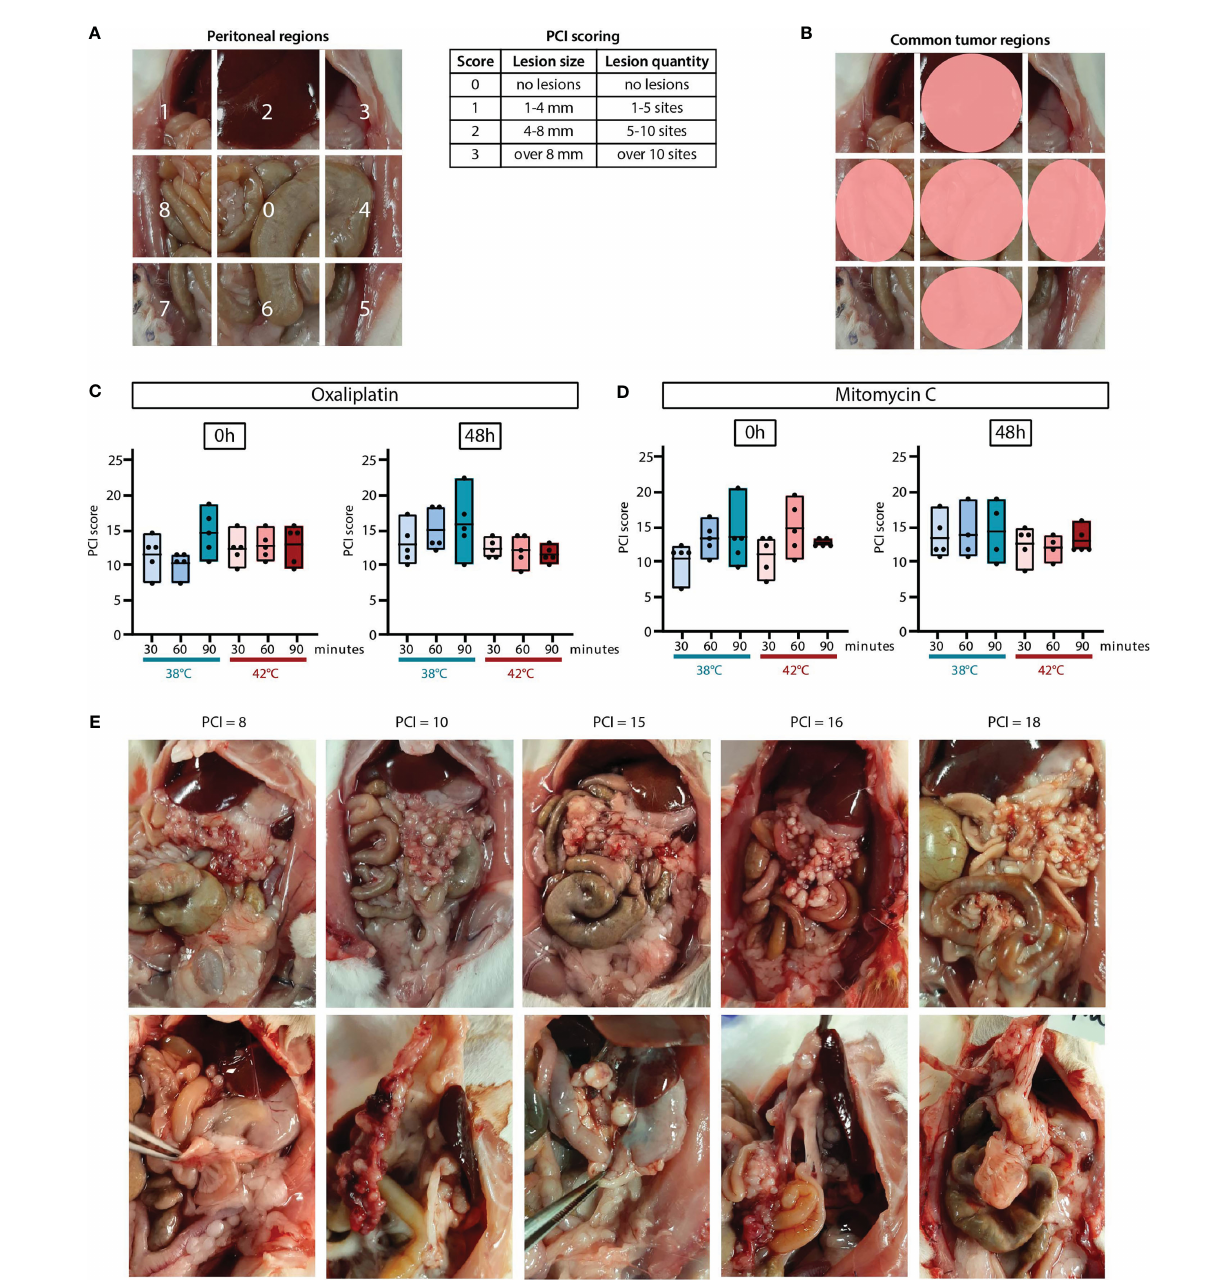
FIGURE 3 The extent of disease was scored upon sacri fi ce using the peritoneal carcinomatosis index (PCI) score. The number and size of the tumor lesion were scored in 9 regions with a score of 0, 1, 2 or 3 (A) . Tumor lesions were most common in regions 2, 0, 4, 6 and 8 (B) . PCI scores measured 0 hours and 48 hours after HIPEC treatment with oxaliplatin (C) or MMC (D) . All values of 4-5 animals are presented with the min/max ± means. Representative pictures with corresponding PCI scores of the abdomen with visible tumor lesions on the omentum (upper panel) and other regions (lower panel) (E)